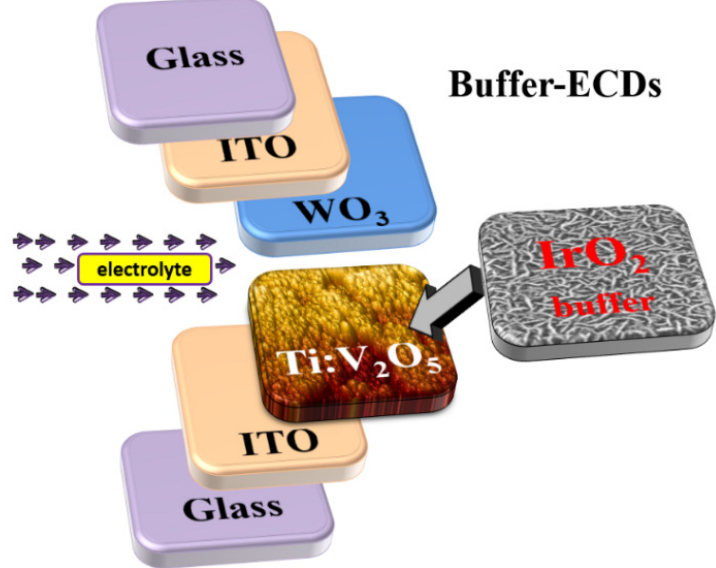
Figure 1. The schematic structure of buffered ECDs.